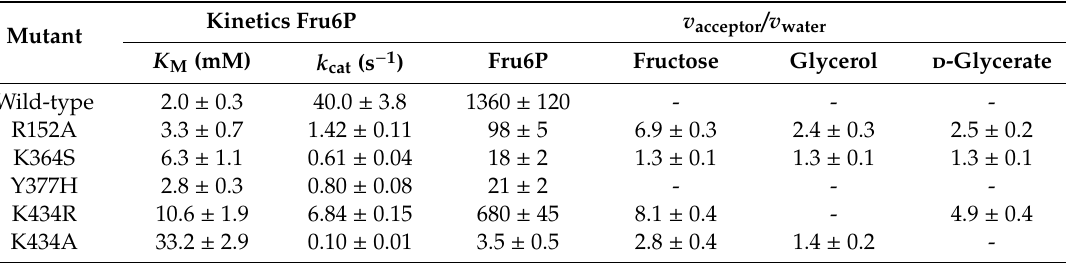
Table 2. (Left) Apparent kinetic parameters of I. coccineus sucrose 6 F -phosphate phosphorylase mutants using 50 mM glucose 1-phosphate at 35 ◦ C and pH 6.5. (Right) Transglucosylation activity using 50 mM glucose 1-phosphate and 30 mM (fructose 6-phosphate; Fru6P), 50 mM ( d -glycerate), or 200